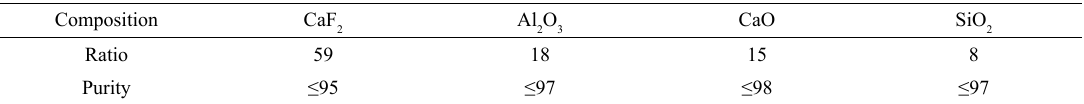
Table 2. Ratio of the elements in slag